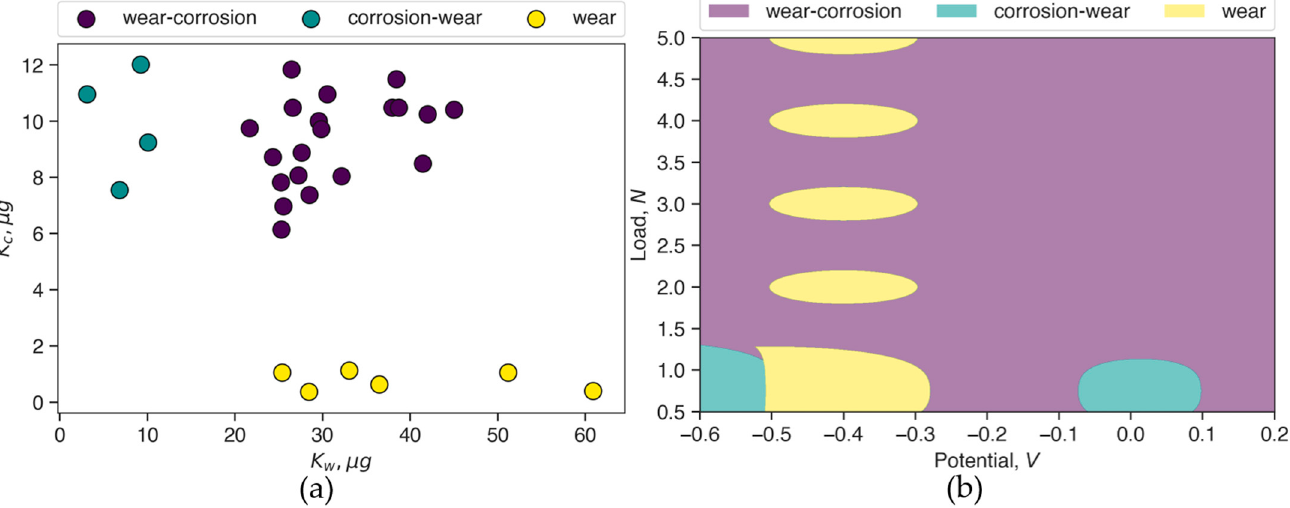
Figure 4. ( a ) Three clusters in dataset 2 identified using K-means clustering; and ( b ) the tribocorrosion mechanism map of Co − Cr generated using SVM.